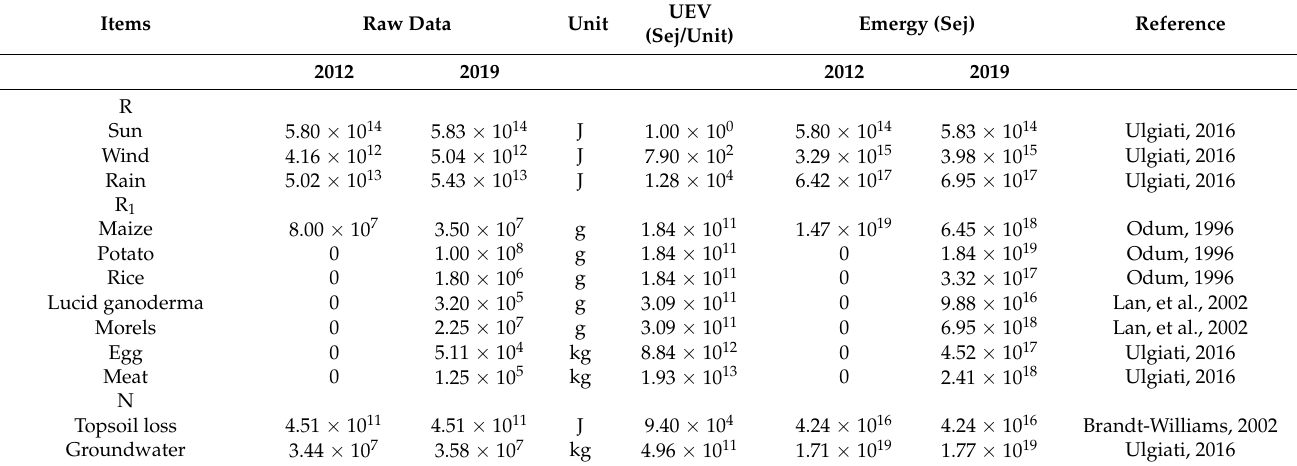
Table A1. Items of emergy accounting of Chehe Village in the year of 2012 and